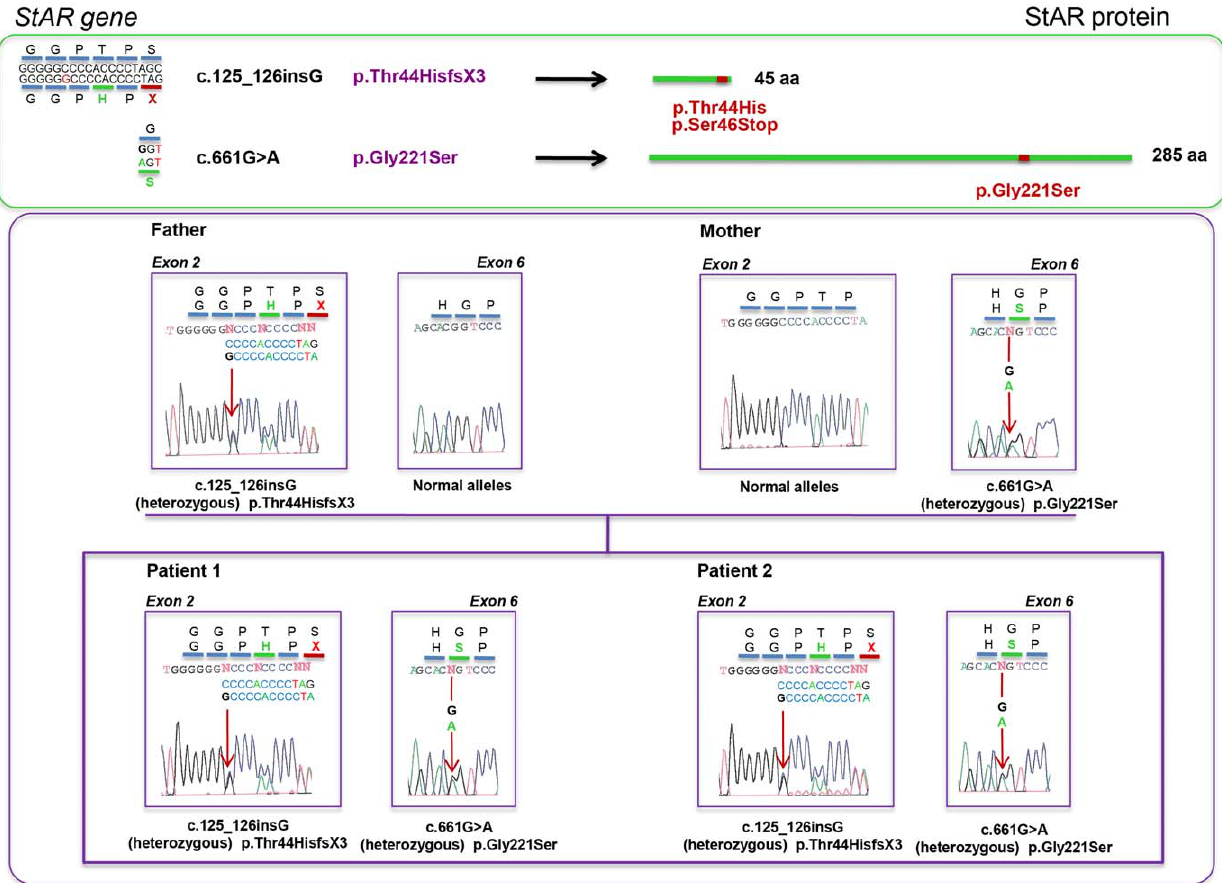
Figure 1. Genetic analysis of the StAR gene. Upper panel, scheme of the identified mutations at the nucleotide (c.DNA) and protein (p.) level. Lower panel, family tree with individual electropherograms showing the novel StAR mutations.